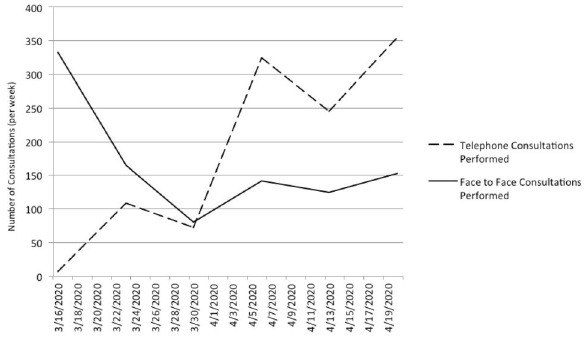
Graph showing the increase in number of telephone Fig. 4: consultations across fracture and elective clinics and decrease in the number of face-to-face consultations throughout COVID measures (per